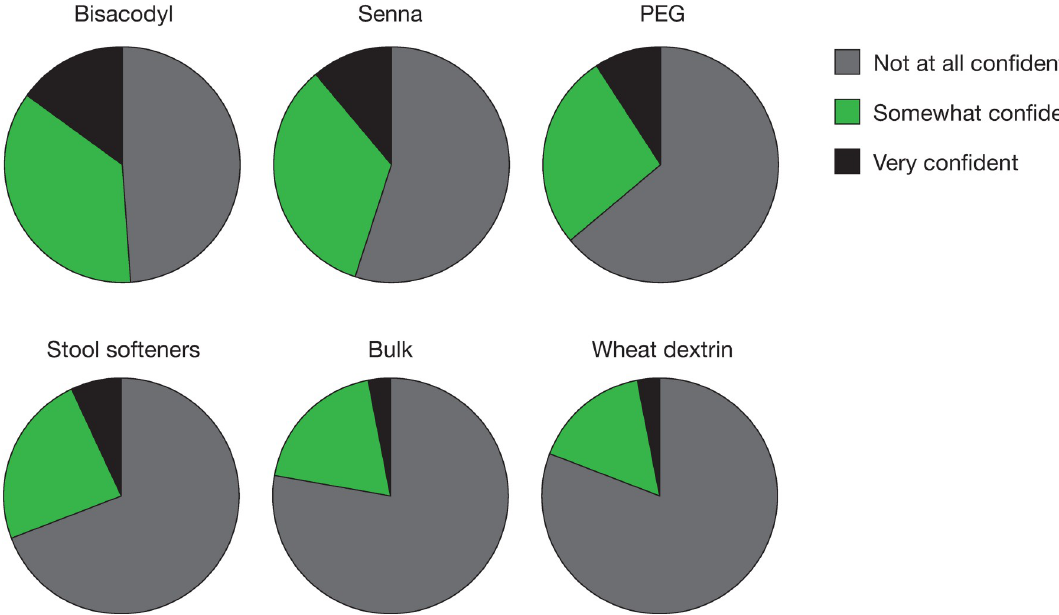
PLOS ONE | https://doi.org/10.1371/journal.pone.0243318 January 11,